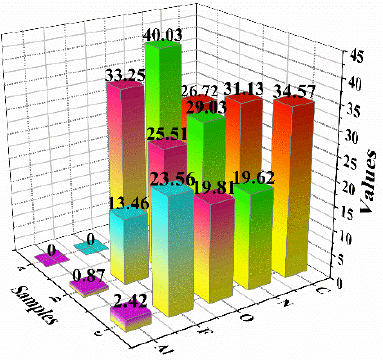
Figure 2. Quantification of element species on the surface of the three samples through analysis of XPS: ( a ) recrystallized FOX-7, ( b ) FOX-7/Viton@Al and ( c ) Viton@FOX-7@Al. The C1s peaks of recrystallized FOX-7 appeared at 284.77 (C–C), 286.80 (C–NH 2 ), 288.49 (C–NO 2 ), 292.00 ( π – π * molecular transition) (Figure 3b), which is in agreement